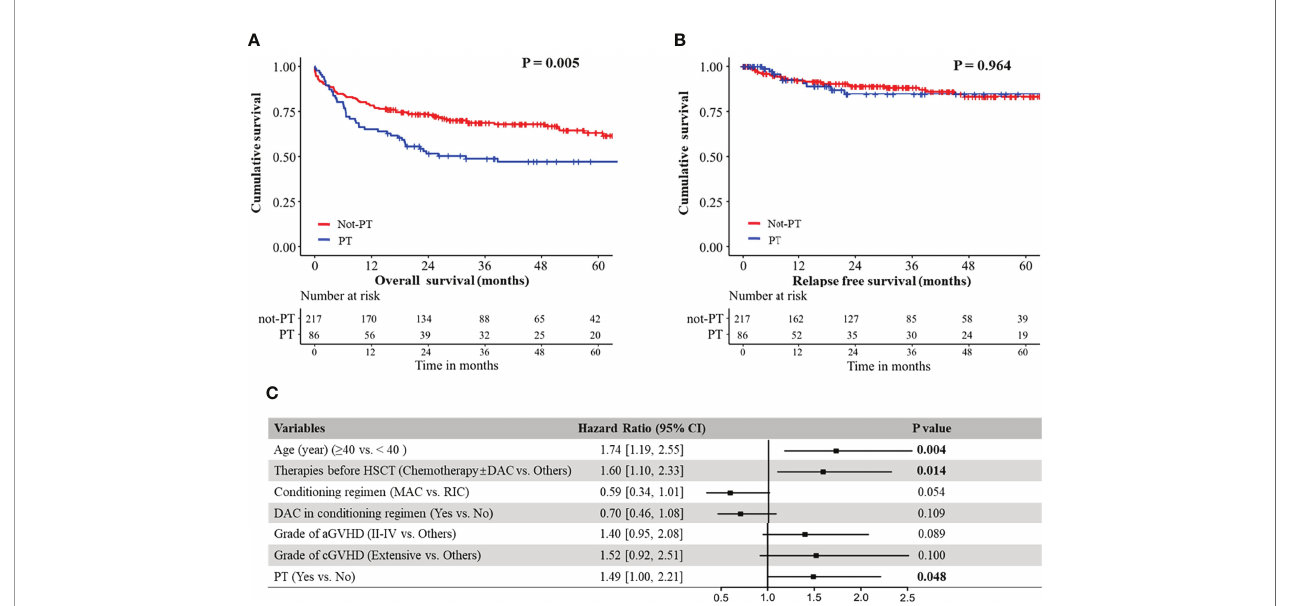
FIGURE 1 | (A) Overall survival of MDS patients with and without PT; (B) Relapse free survival of MDS patients with and without PT. (C) Forest plot for hazard ratio of different risk factors on overall survival in MDS patients, as established using a Cox regression